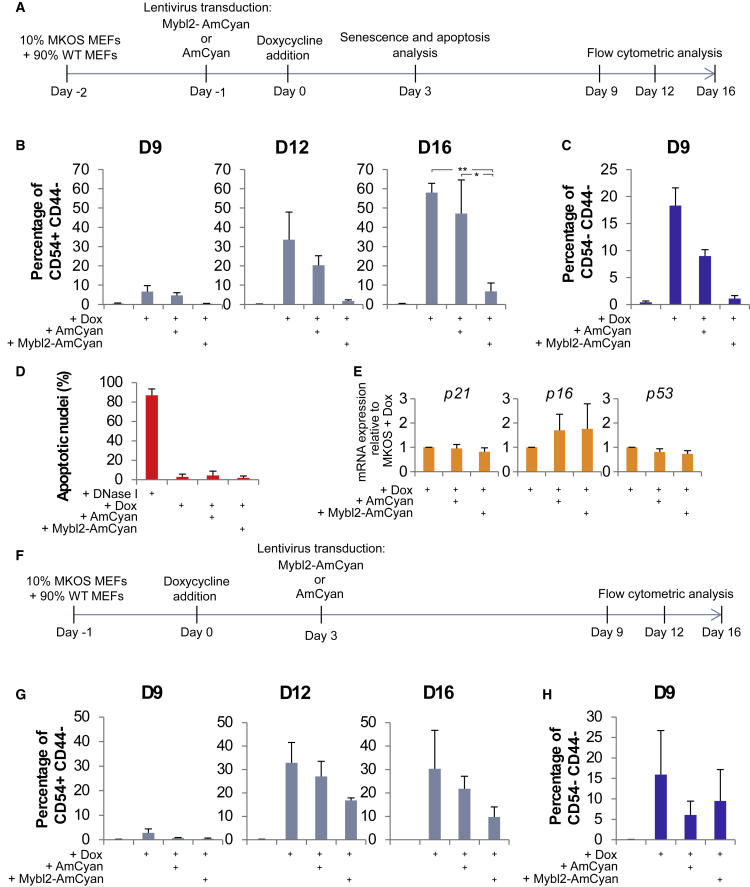
Mybl2 Overexpression Inhibits Tg Reprogrammable MEFs(A) Schematic representation of the experimental design.(B and C) Reprogramming kinetics studies using CD44-APC and CD54-PE-Cy7 at days 9, 12, and 16. Bar graphs represent the percentage of cells in the CD44−/CD54+ (B) or the CD44−/CD54− quadrant (C). n = 3. ∗p < 0.05, ∗∗p < 0.01.(D) Quantification of apoptotic nuclei counts at day 3 or reprogramming. n = 2 biological replicates.(E) RNA expression of p21 (left), p16 (middle), and p53 (right) was measured by qRT-PCR, normalized against the β2-microglobulin housekeeping gene and expressed relative to non-transduced Tg reprogrammable MEFs (MKOS). n = 3 biological replicates, each with 3 technical replicates.(F) Schematic representation of the experimental design.(G and H) Graphs represent the percentage of CD44−/CD54+ cells (G) at days 9, 12, and 16 or the percentage of CD44−/CD54− cells (H) at day 9. n = 3 biological replicates.See also Figures S5 and S6.